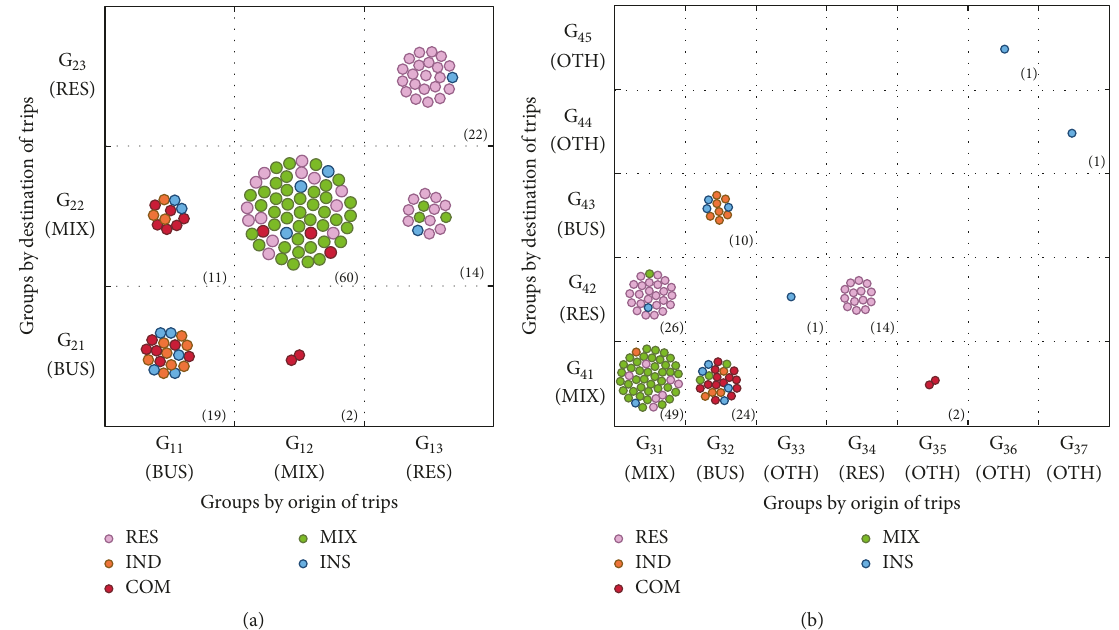
Figure 3: Aggregation of zones common to both groups derived by originating and terminating trips: (a) weekday data and (b) weekday- weekend data; the number of zones for each case is stated in